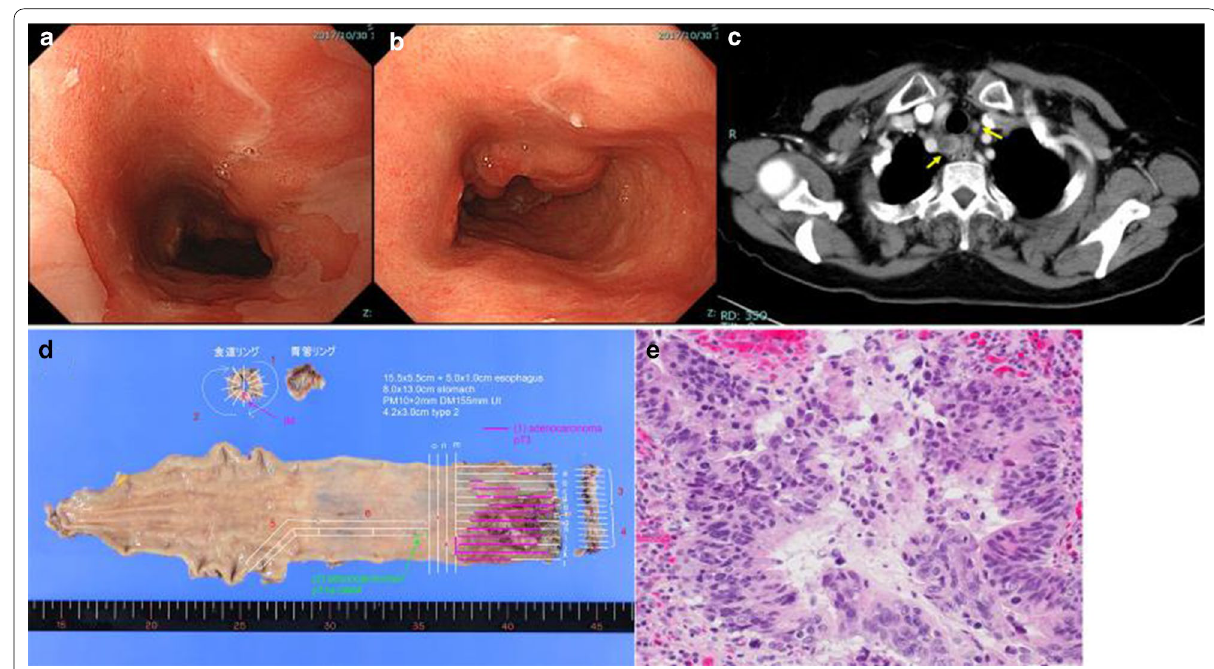
Fig. 2 Endoscopy, computed tomography, and histopathological findings for case 2. a , b Endoscopy revealed a squamocolumnar junction 15 cm from the incisor teeth and a type-2 semicircular tumor on the upper esophagus. c Computed tomography detected enlarged cervical paraesophageal lymph nodes (#101) with no other distant metastatic sites. d , e The postoperative pathological diagnosis was of well-differentiated adenocarcinoma (60 52 mm) with supraclavicular lymph nodes metastasis (pT3 pN3 pM1 pStage ×